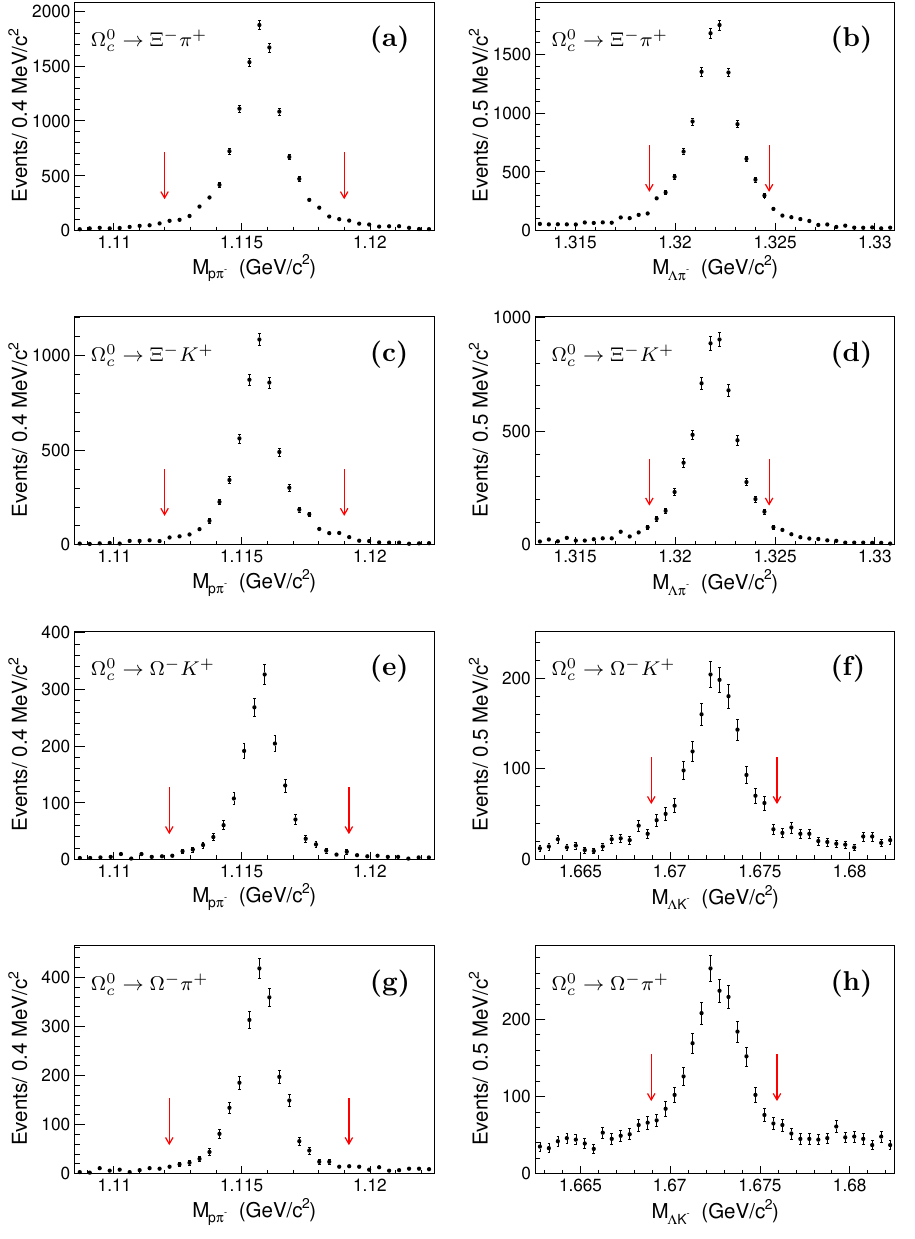
Figure 1 . The left column shows the Λ candidates in (a) Ω 0 c → Ξ − π + , (c) Ξ − K + , (e) Ω − K + , and (g) Ω − π + decays. In the right column the invariant mass of Ξ − candidates (in (b) Ω 0 (d) Ξ − K + decays) and Ω − candidates (in (f) Ω 0 red arrows show the required Λ , Ξ − and Ω − signal